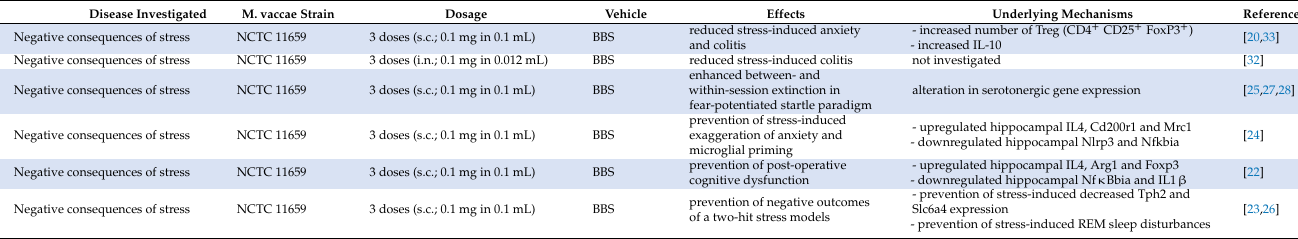
Table 3. List of observational studies employing rapidly growing mycobacteria strains (RGMs) in preclinical studies 1 . DiseaseInvestigated